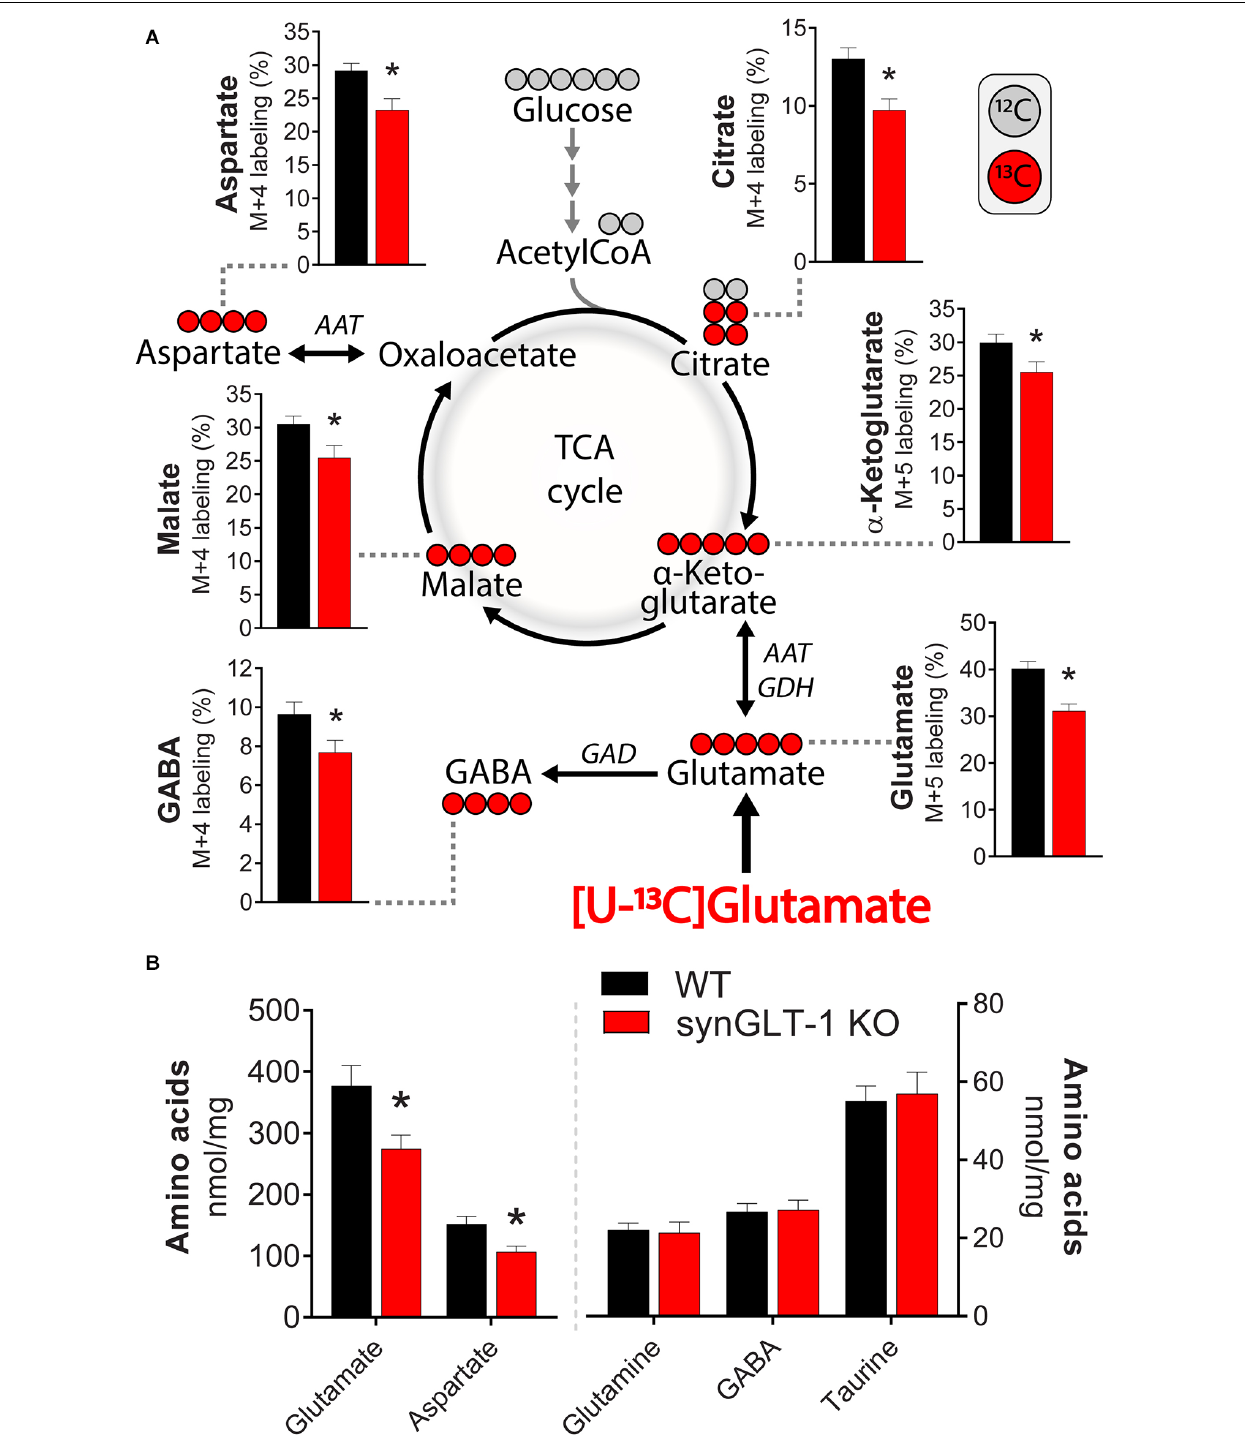
FIGURE 8 | Deletion of neuronal GLT-1 impaired glutamate uptake and glutamate utilization in hippocampal slices. (A) Metabolic mapping of [U- 13 C]glutamate in hippocampal slices of WT mice (black bars) and synGLT-1 KO mice (red bars). The slices were incubated in the presence of 200 µ M [U- 13 C]glutamate in addition to 5 mM D-glucose ( 12 C). Metabolism of 13 C enriched substrates will lead to 13 C incorporation in TCA cycle metabolites and derived amino acids, visualized by red circles ( 13 C) and gray circles ( 12 C). (B) Amino acid content in hippocampal slices of WT mice (black bars) and synGLT-1 KO mice (red bars) incubated with 200 µ M [U- 13 C]glutamate in addition to 5 mM D-glucose. AAT, aspartate aminotransferase; GAD, glutamate decarboxylase; GDH, glutamate dehydrogenase. Mean ± SEM, n = 10, each point derived from individual animals, Student’s t -test with Benjamini-Hochberg correction, * p < 0.05. See text for exact p values.